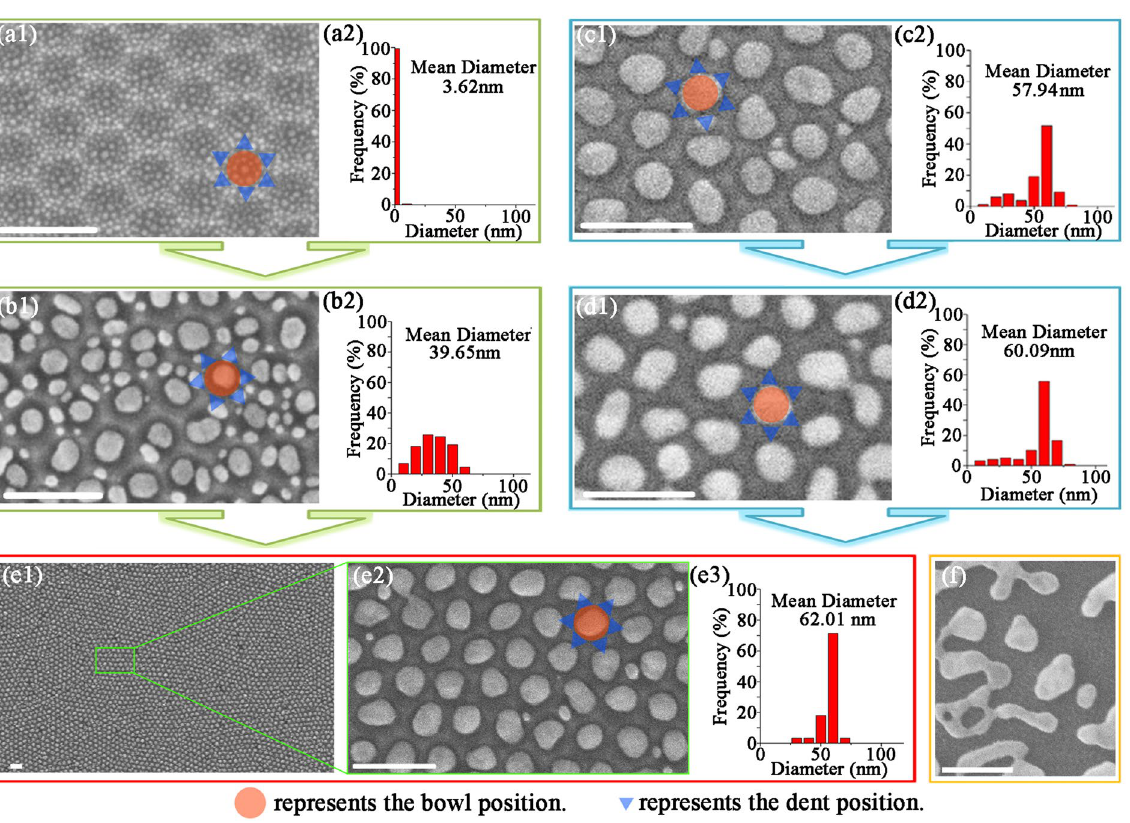
Figure 4. Structural evolutions after SSD process (400 °C for 2 h) for Au-coated Al nanobowl array ( V AAO = 40 V) with different Au film thickness: ( a1 ) 2.5 nm, ( b1 ) 7.5 nm and ( e2 ) 12.5 nm. Structural evolutions for Au-coated Al nanobowl array ( t Au = 12.5 nm, V AAO = 40 V) with different thermal treatment temperatures during SSD process: ( c1 ) 300 °C for 2 h and ( d1 ) 350 °C for 2 h. ( e1 ) Large-scale SEM image corresponding to ( e2 ). ( a2–d2 ) and ( e3 ) are corresponding calculated diameter distributions in ( a1–d1 ) and ( e2 ), respectively. ( f ) Au nanoparticles acquired under the same conditions as in ( e1 ) without using Al nanobowl array template. The scale bars in SEM images are all 200